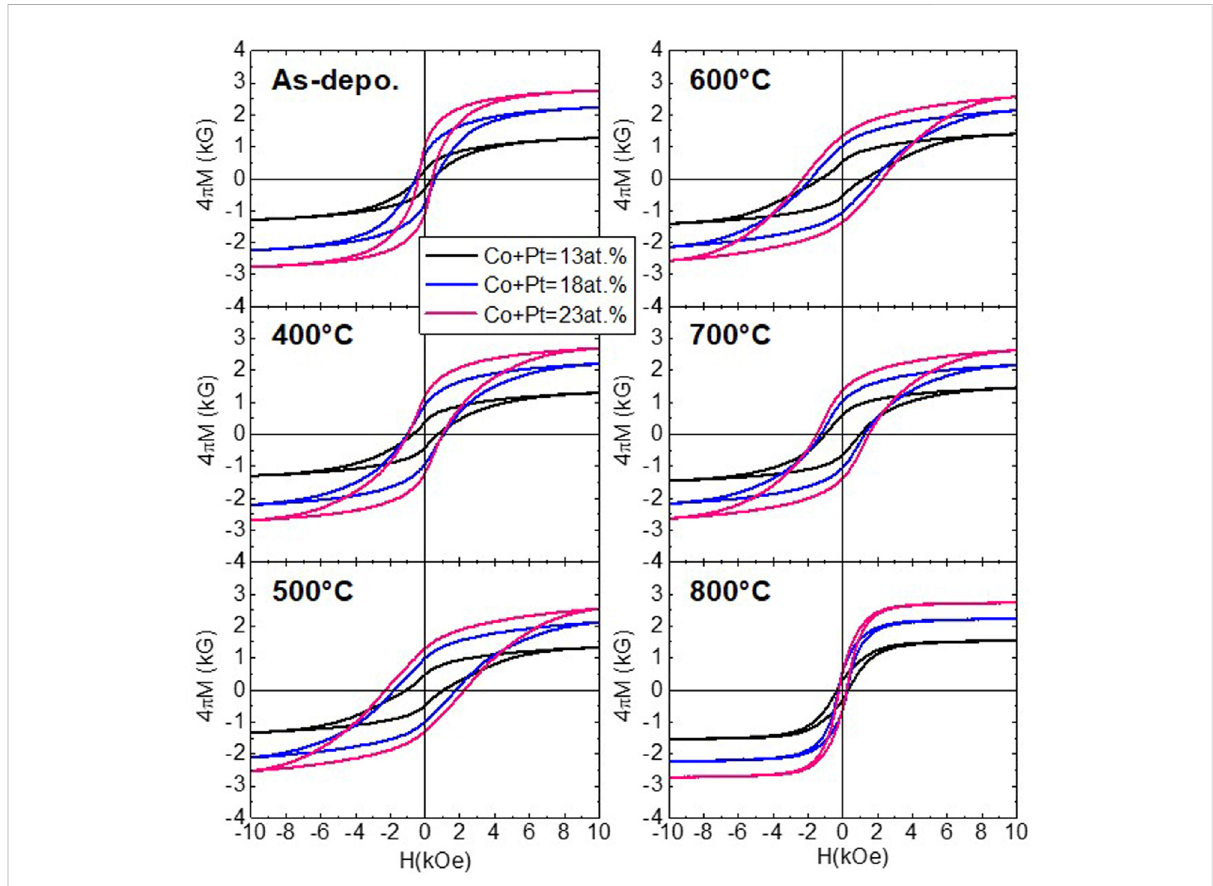
FIGURE 4 Magnetic hysteresis loops in (Co-Pt)-(CaF 2 ) (Co. + Pt = 13,18 and 23 at%) nanogranular fi lms as deposited state and annealed at 400, 500, 600, 700 and 800 °